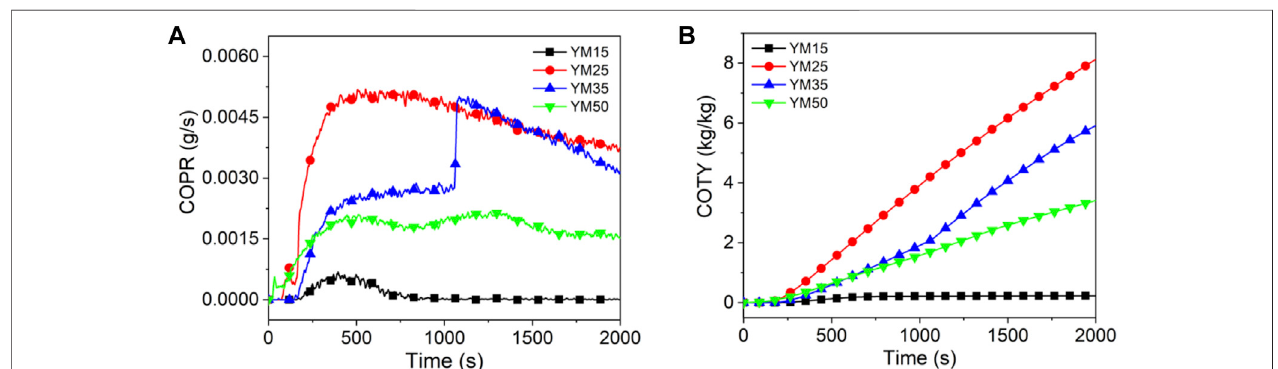
FIGURE 8 | Bitumite curves: (A) PCOPR, and (B) COTY.